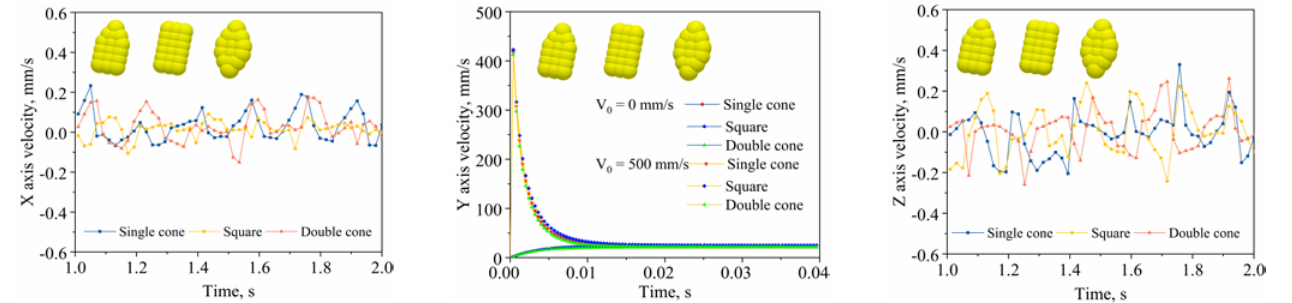
Figure 7. Three-dimensional velocity variation diagram of particles with different peripheral mor- phologies.